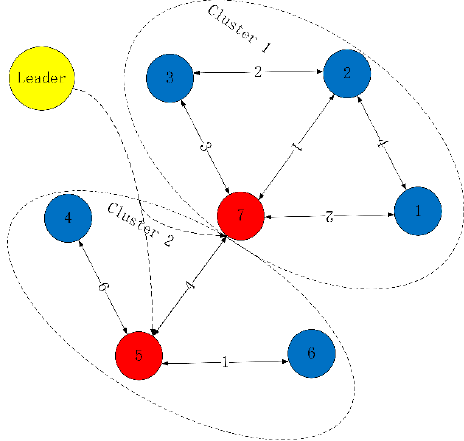
Figure 3. Communication graph for test cases, ( a ) is the topology of communication of BESSs, ( b ) is drawn by MATLAB, ( c ) is the MST of ( b ), ( d ) is the result of performing clustering algorithm, ( e ) is the classification with a leader, BESS 7 is the leader of cluster 1 and BESS 5 is the leader of cluster